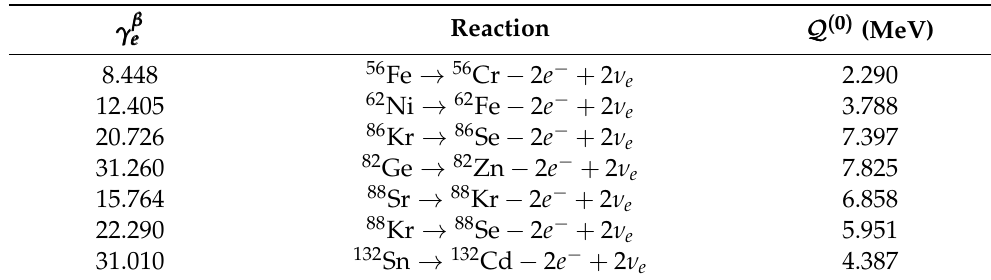
Table 5. Same as in Table 4 but considering ground-state to excited state transitions (for which the excitation energy is experimentally known and E exc > 0).